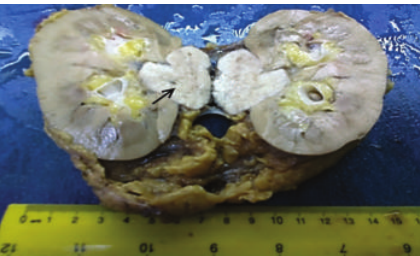
Figure 1: Gross specimen showing well-defined, lobulated tumor in relation to the right renal hilum.